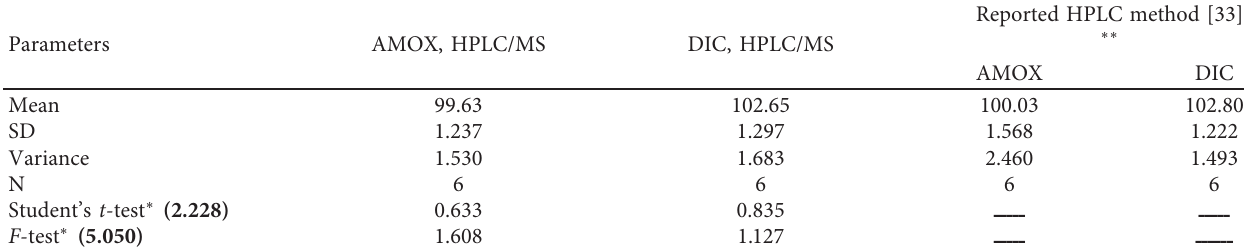
Table 6: Statistical analysis of the proposed HPLC/MS method and the reported HPLC method for the determination of AMOX and DIC in pharmaceutical formulations.